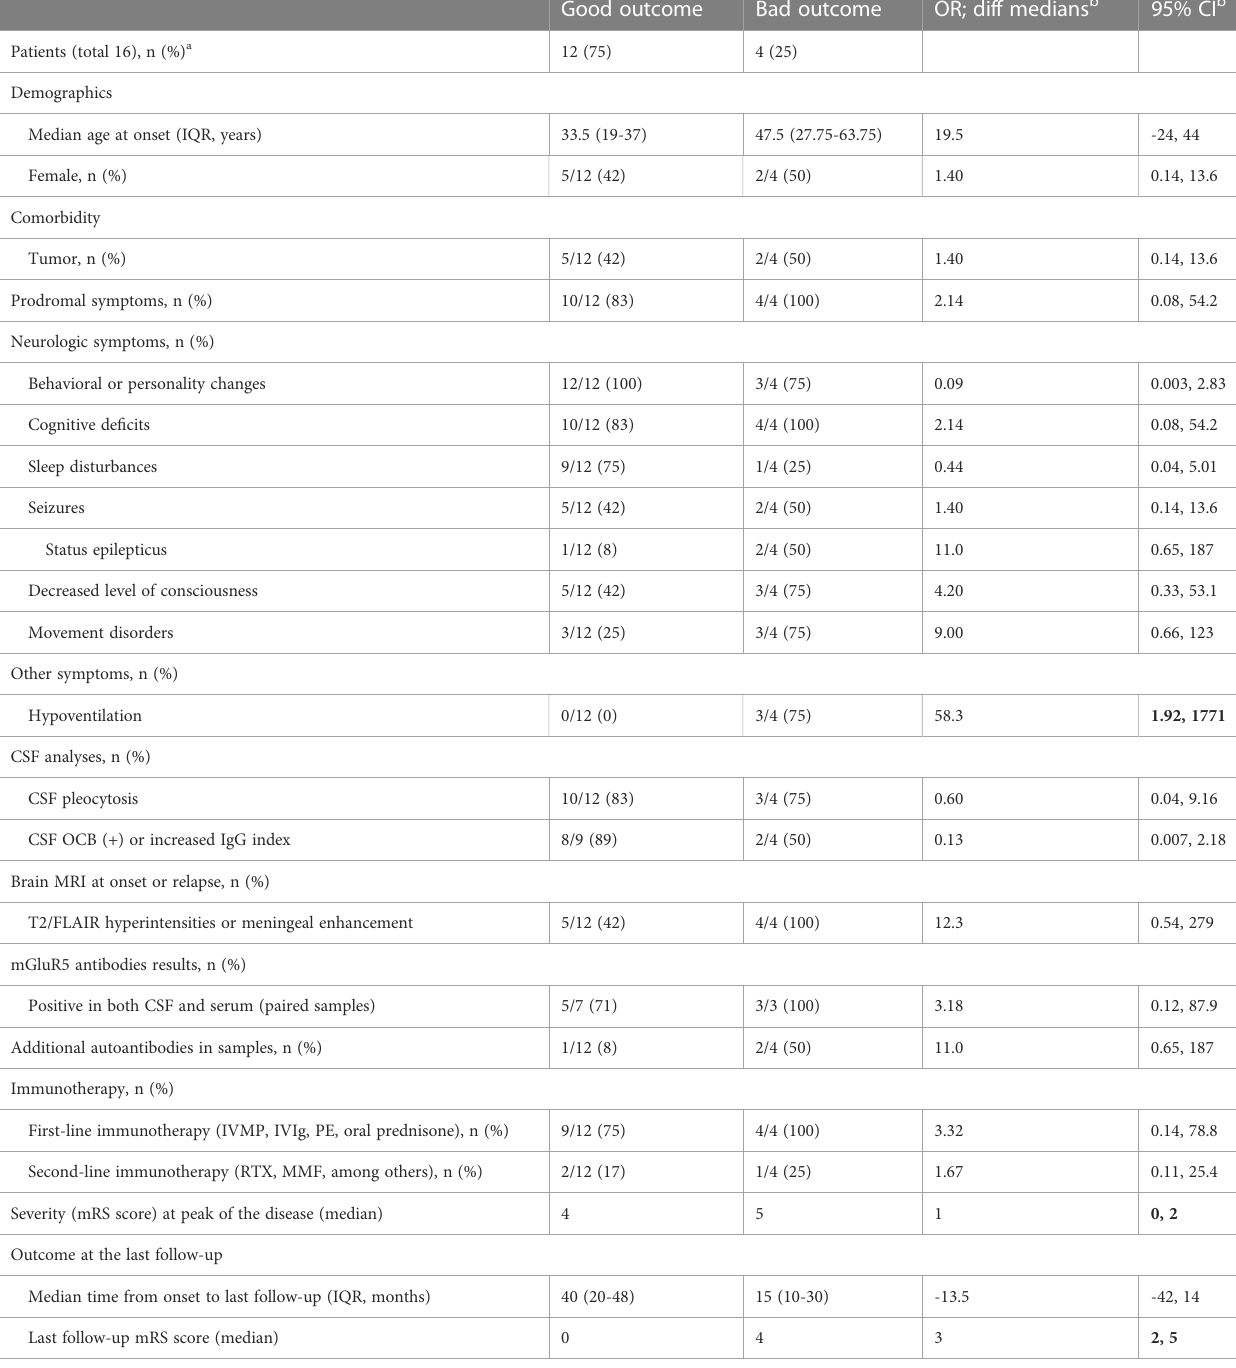
TABLE 3 Comparison of autoimmune encephalitis patients with mGluR5 antibodies according to good or bad outcome. Good